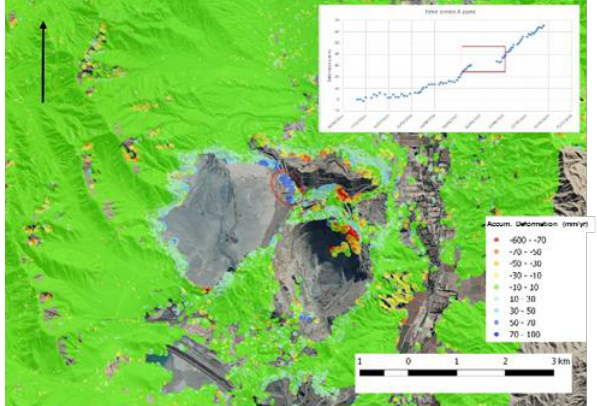
Figure 6. Zoom of the area marked by an ellipse in figure 4.